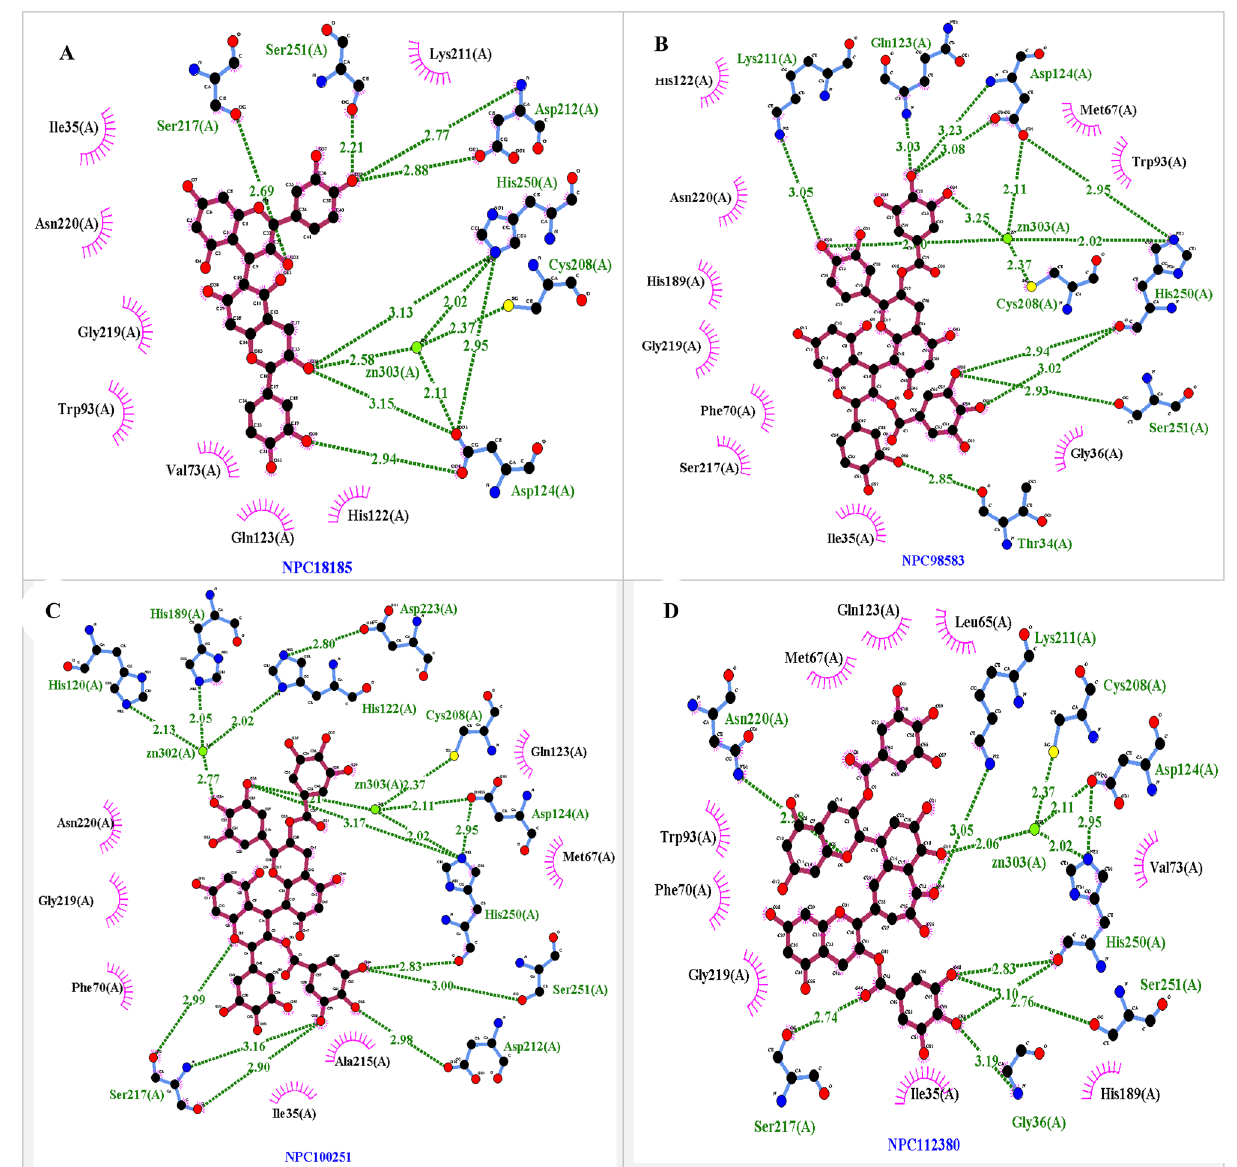
Figure 4. The predicted complex NDM1-NPC binding mode. The position of the NPs in the active site of the NDM, hydrogen bonds and hydrophobic interactions were shown. ( A ) NDM1-NPC18185, ( B ) NDM1-NPC98583, ( C ) NDM1-NPC100251, ( D ) NDM1-NPC112380, ( E ) NDM1-NPC171932, ( F ) NDM1- NPC300657, ( G ) NDM1-NPC471403, ( H ) NDM1-NPC471404, ( I ) NDM1-NPC472454, ( J ) NDM1-